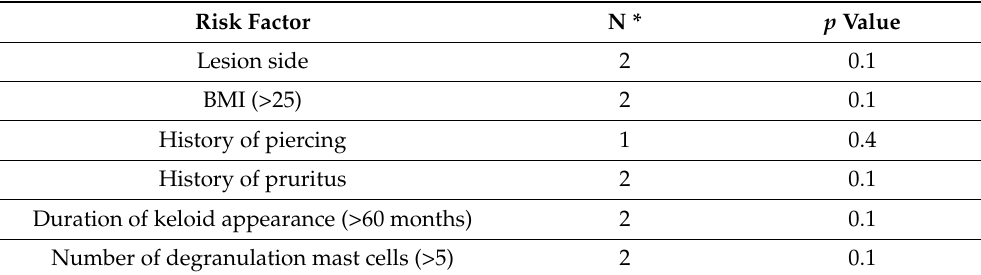
Table 4. Fisher’s Exact test for the possible risk